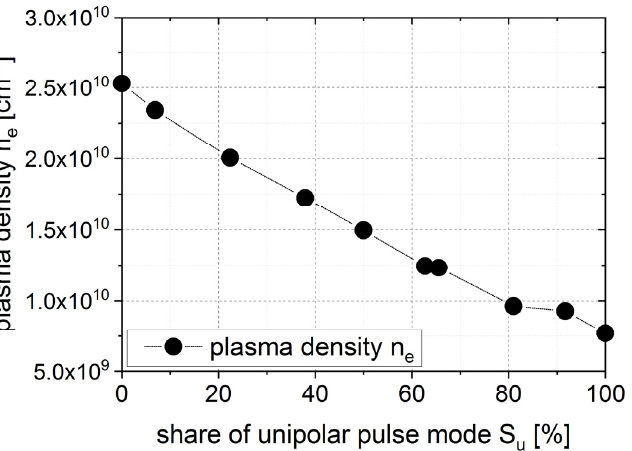
Figure 1. Plasma density in dependence of share of unipolar pulse mode in unipolar–bipolar hybrid pulse mode operation (example of Si process, adapted from [14]).